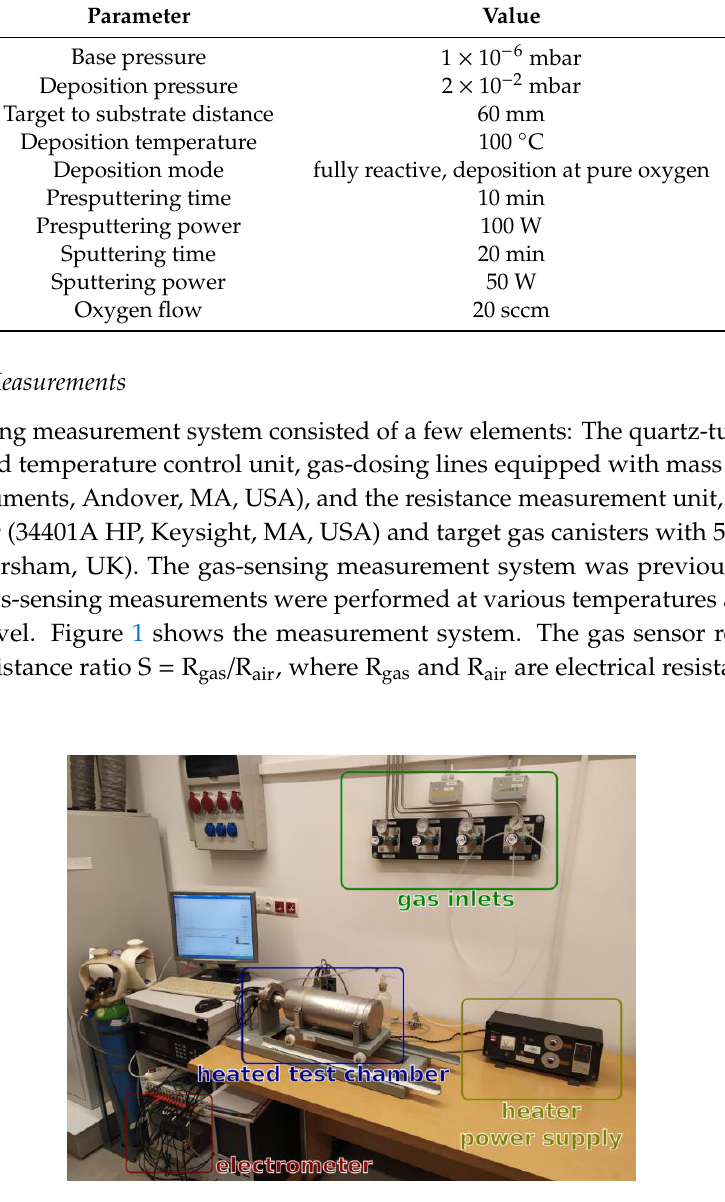
Figure 1. The measurement setup for gas-sensing characteristics. Reprinted from [101] CC BY 4.0.